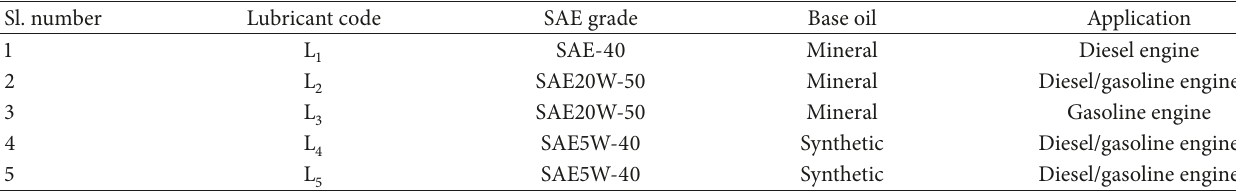
Table 1: Lubricants selected for the